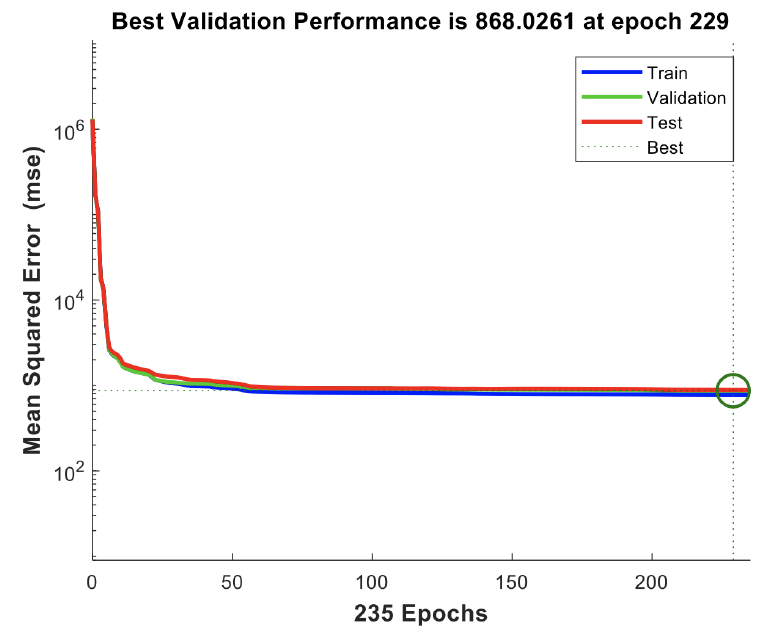
Figure 10. A graphical representation of the training errors, validation errors, and test